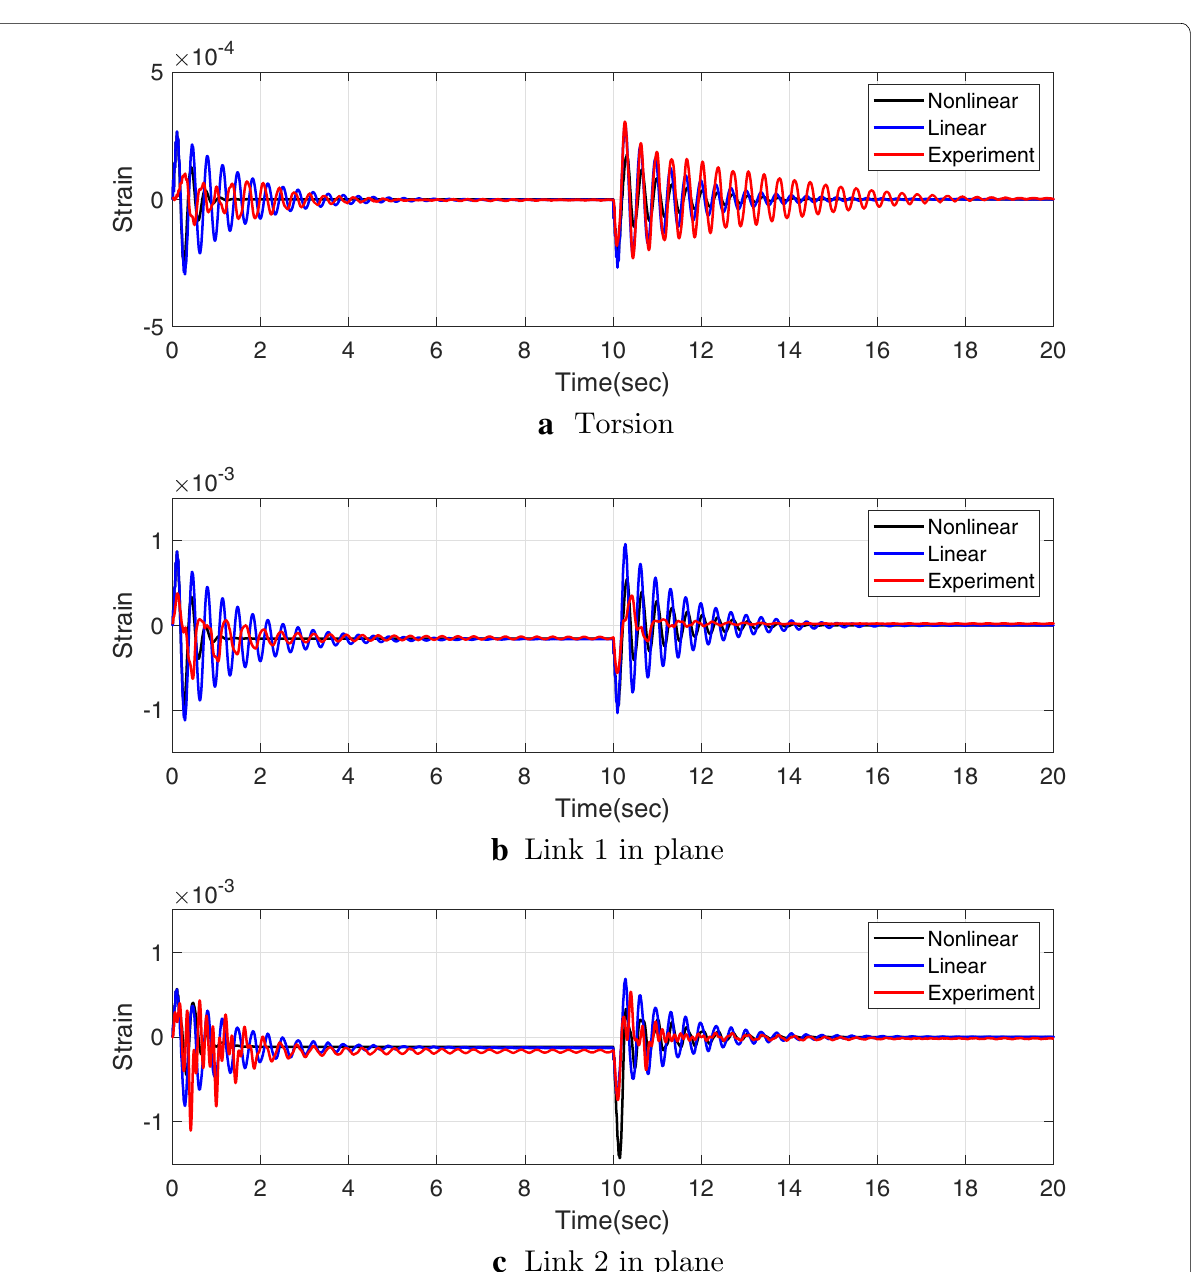
Fig. 4 Validation of links and torsional strain. This figure shows the link and torsional strain of the nonlinear model and the linearized model against the actual